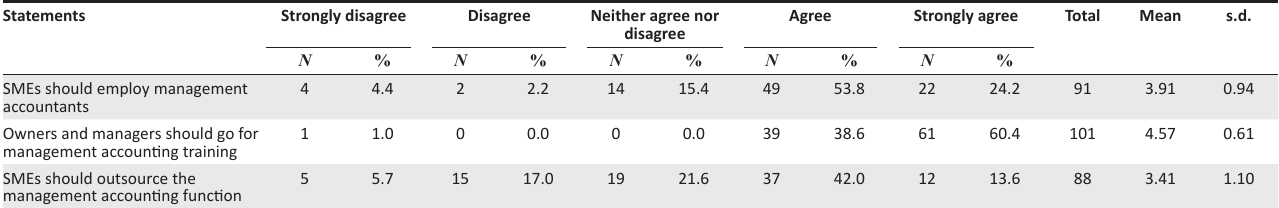
TABLE 8: Recommendations by small and medium-sized enterprise owners and